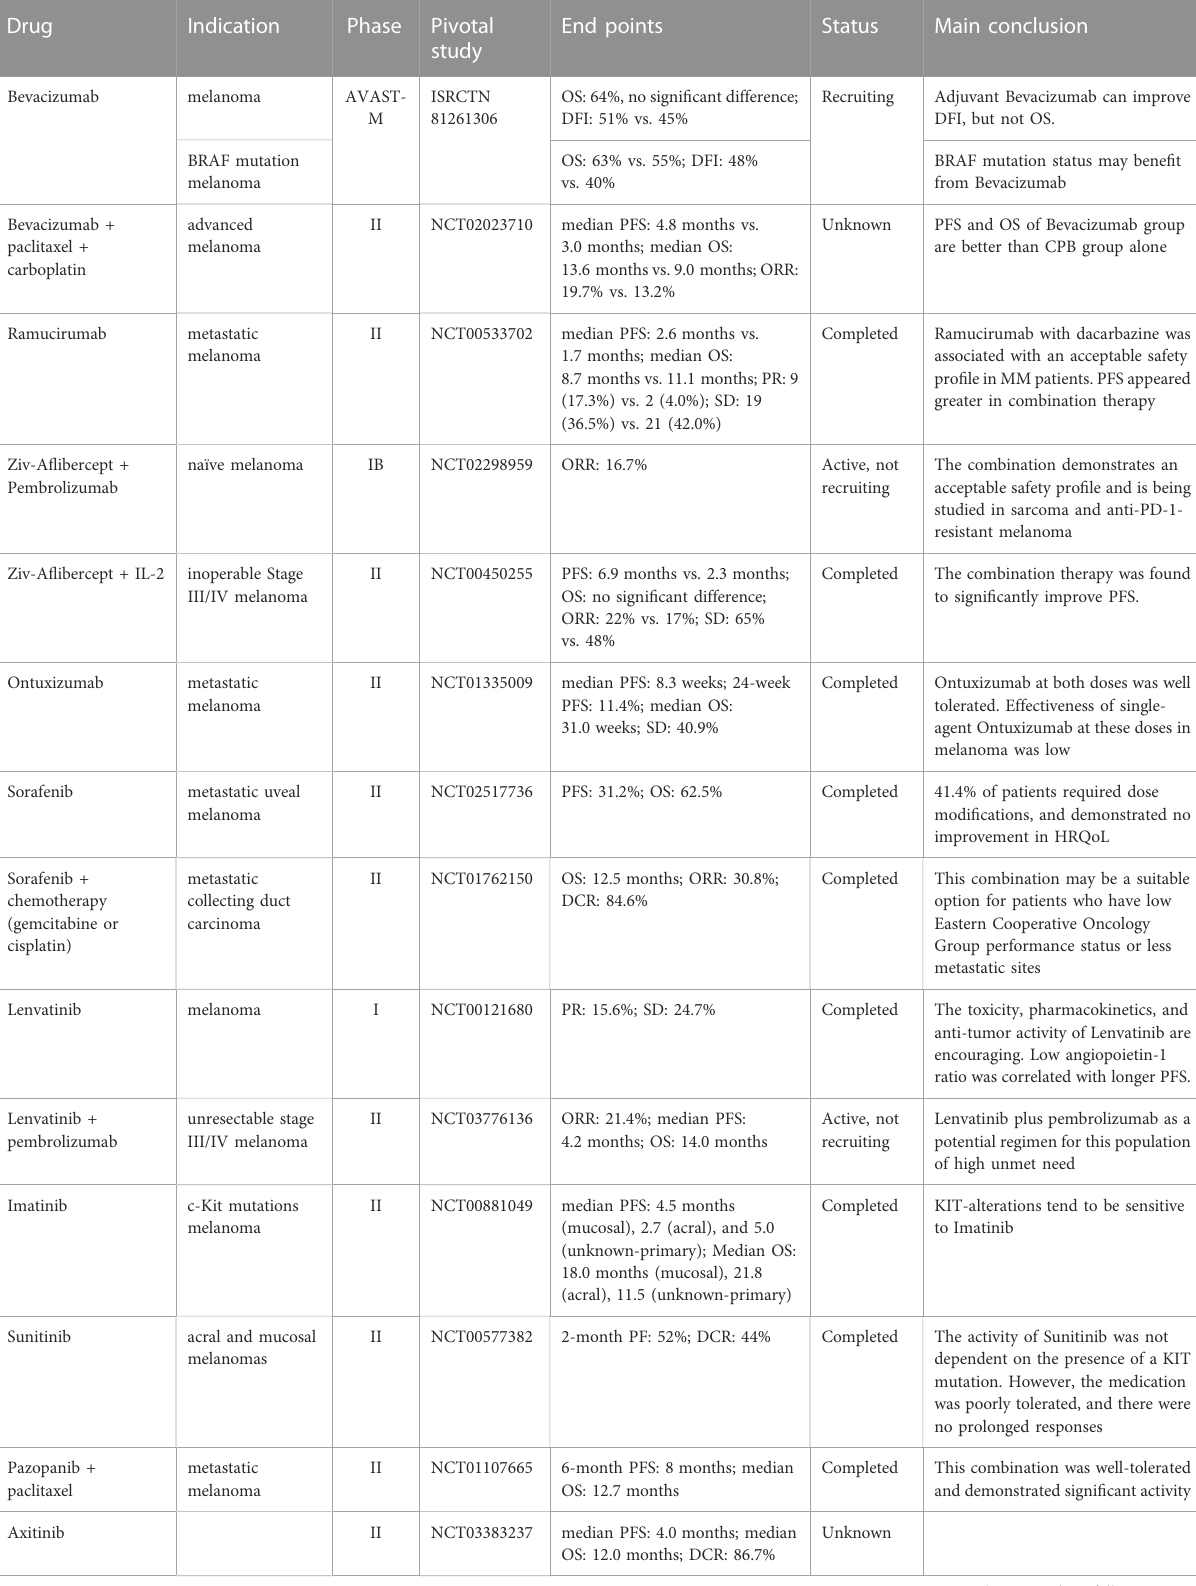
TABLE 2 Overview of clinical studies in melanoma cancer of anti-angiogenic